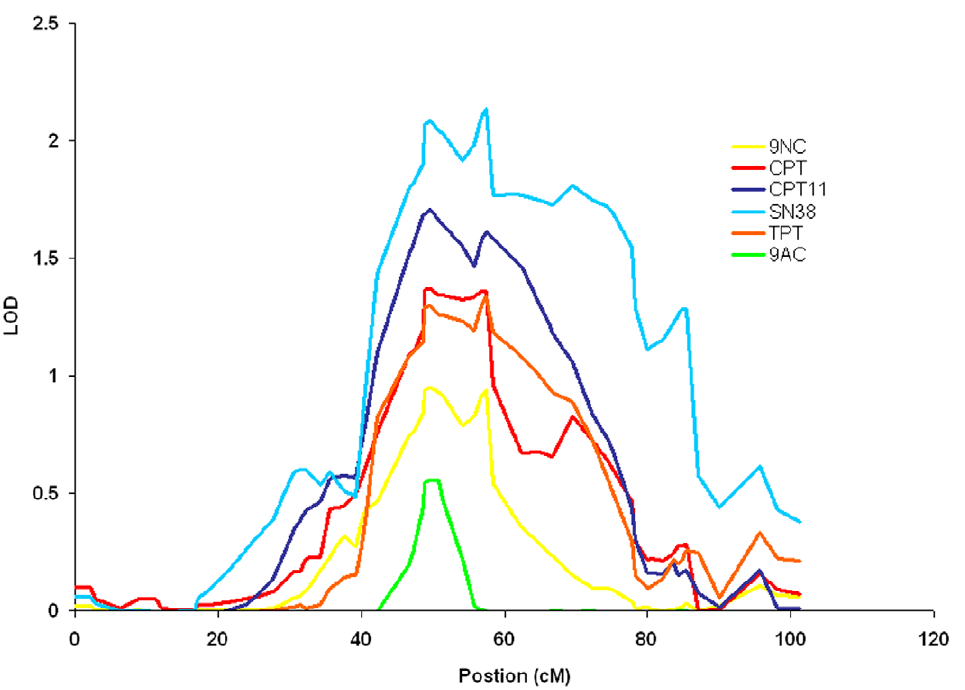
Figure 2. QTL shared across all camptothecins on chromosome 20. The QTL on chromosome 20 contains the gene for Top1, the sole molecular target of all camptothecins. Each drug is represented by a different color. Multiple concentrations for each drug were identified as significant and suggestive at this location. The drug-dose combinations with the highest LOD scores are represented here.